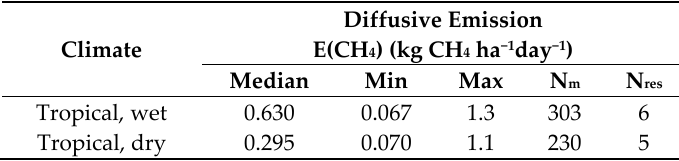
Table 1. Methane (CH 4 ) diffusion flux factor for flooded